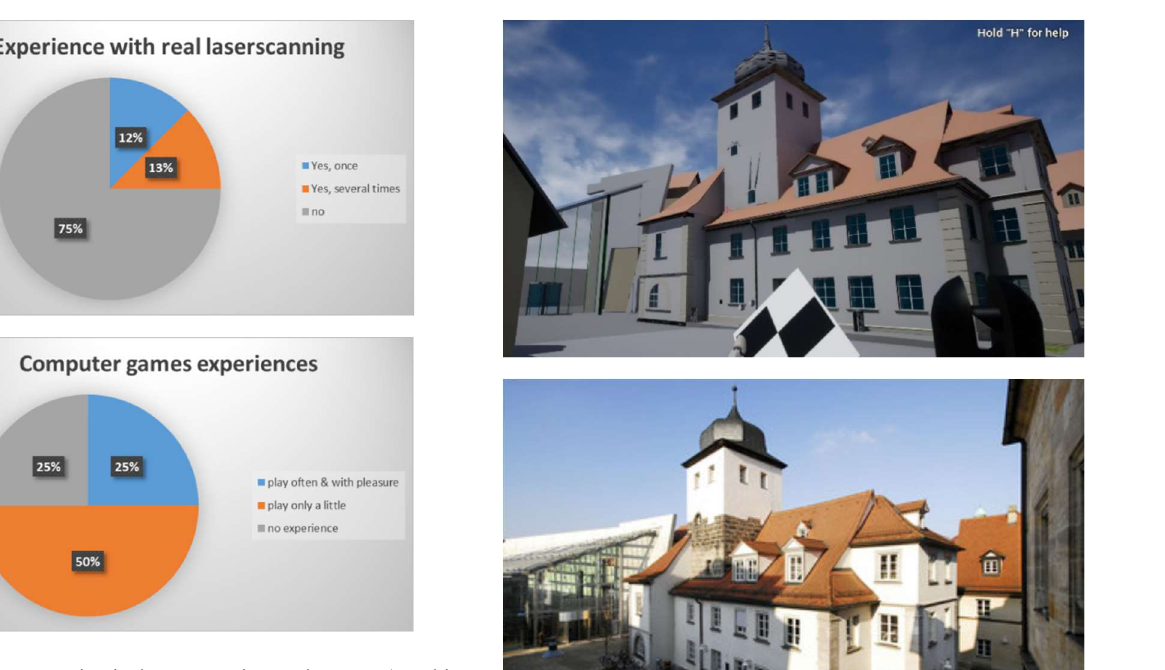
Figure 7. Competencies in laser scanning and games (graphic from the second user testing).